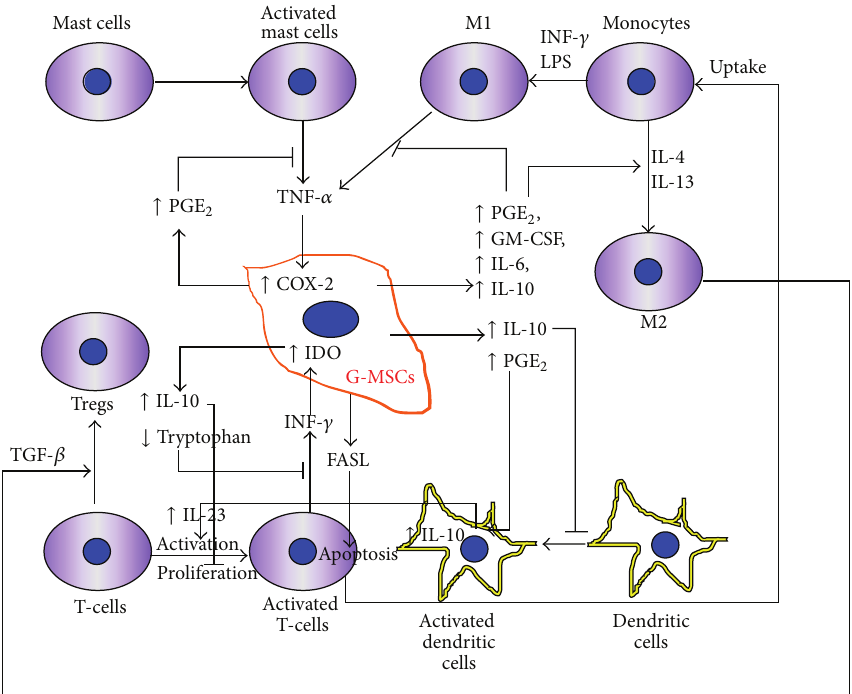
Figure 3: Immunomodulatory “crosstalk” between G-MSCs and mast cells, macrophages (with their M1 and M2 phenotypes), dendritic cells, and T-cells. COX-2: cyclooxygenase-2; PGE 2 : prostaglandin E 2 ; GM-CSF: granulocyte-macrophage colony-stimulating factor; INF: interferon; IL: interleukin; TGF: transforming growth factor; IDO: indoleamine 2,3-dioxygenase; LPS: lipopolysaccharide.